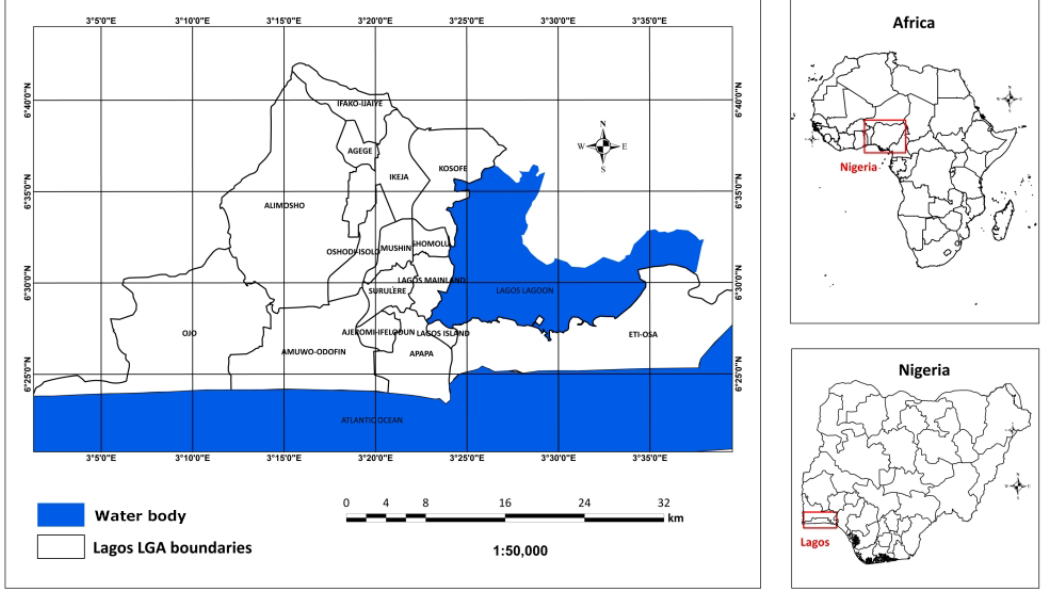
Figure 1. The Lagos metropolis of Nigeria. Inset shows the location of Lagos State in Nigeria.